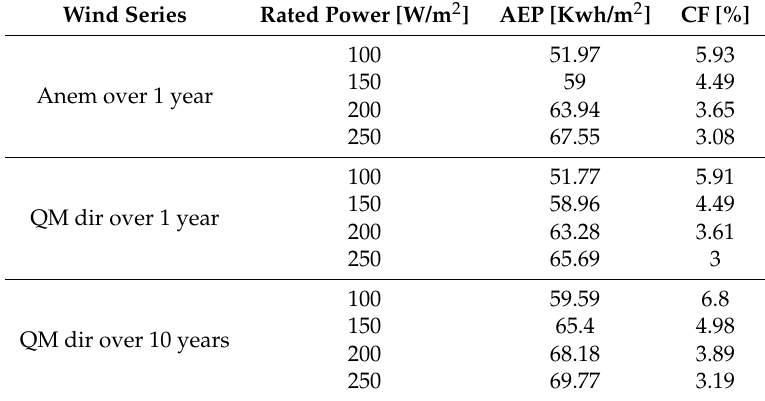
Table 9. AEP and CF values for various wind time series and rated powers for the scenario considered as the most